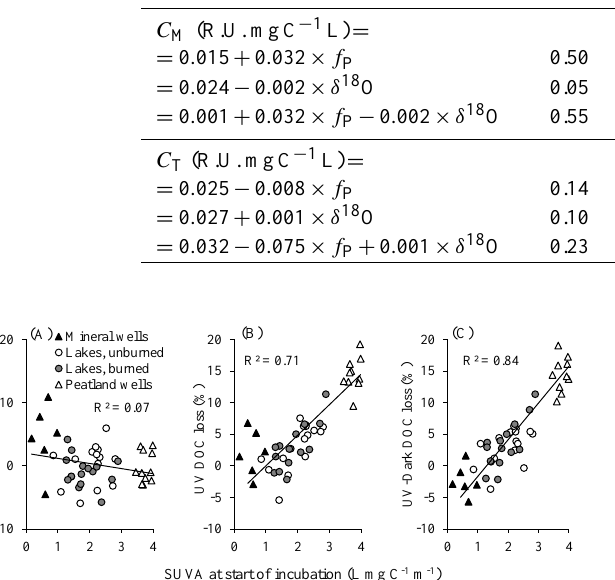
DOC losses (Fig. 9). For mineral soil wells the produc- tion of precipitate, likely calcium carbonate, caused nega- tive CO 2 production, and their CO 2 production was therefore not considered further. For peatland well samples, CO 2 pro- duction was lower than DOC losses during UV incubations (7.2 ± 1.2 % loss versus 14.1 ± 2.3 % loss, respectively; pair- wise t test, n = 12, p < 0.001), suggesting substantial pro- duction of particulate organic carbon (Fig. 9). For lake sam- ples during UV incubations, DOC losses and CO 2 production were not significantly different ( p = 0.69). The double expo- nential fit to CO 2 production time series estimated that 1.2 % of the DOC pool in lake and peatland well samples was la- bile during dark incubations and had a half-life of 3.4 days, while the stabile pool had a half-life of > 5000 days. During UV incubations, lakes and peatland samples had labile frac- tions at 3.2 and 6.7 %, respectively, with common half-lives of 4.7 and 450 days for the labile and stabile DOC pools, respectively. ing UV incubations (pairwise t test, p < 0.001), while